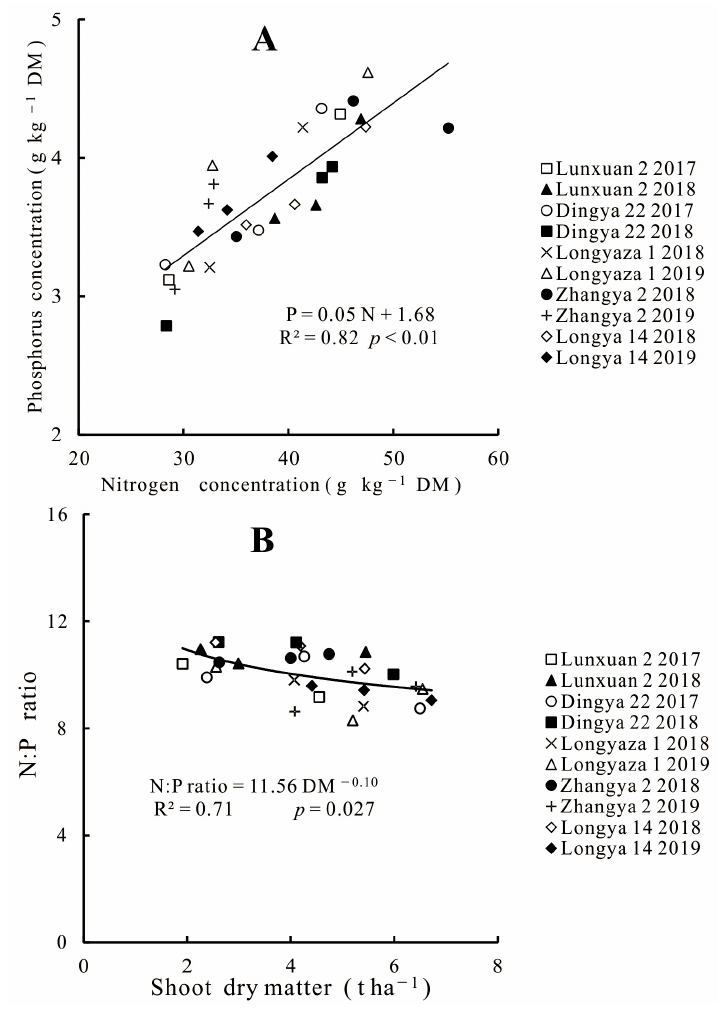
Figure 1. Relationship between P and N concentrations in shoot ( A ) and between the ration N concentration to P concentration in shoot of flax under non-limiting P conditions ( B ). P, phosphorus; N, nitrogen; SB, shoot